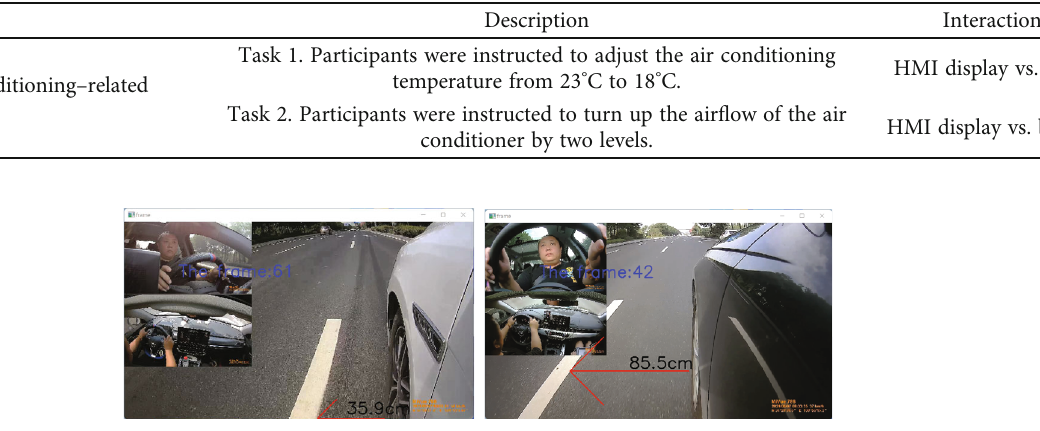
Figure 5: Schematic diagram of the vehicle lateral position data processing